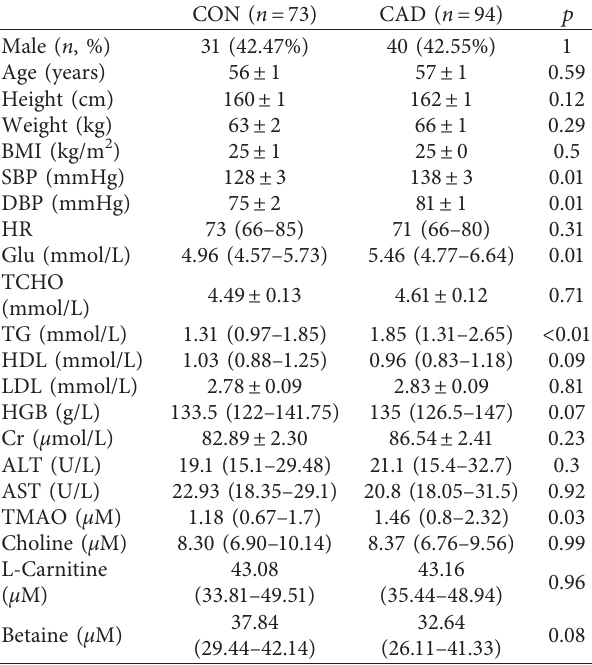
Table 1: Baseline characteristics of subjects stratified by CON and